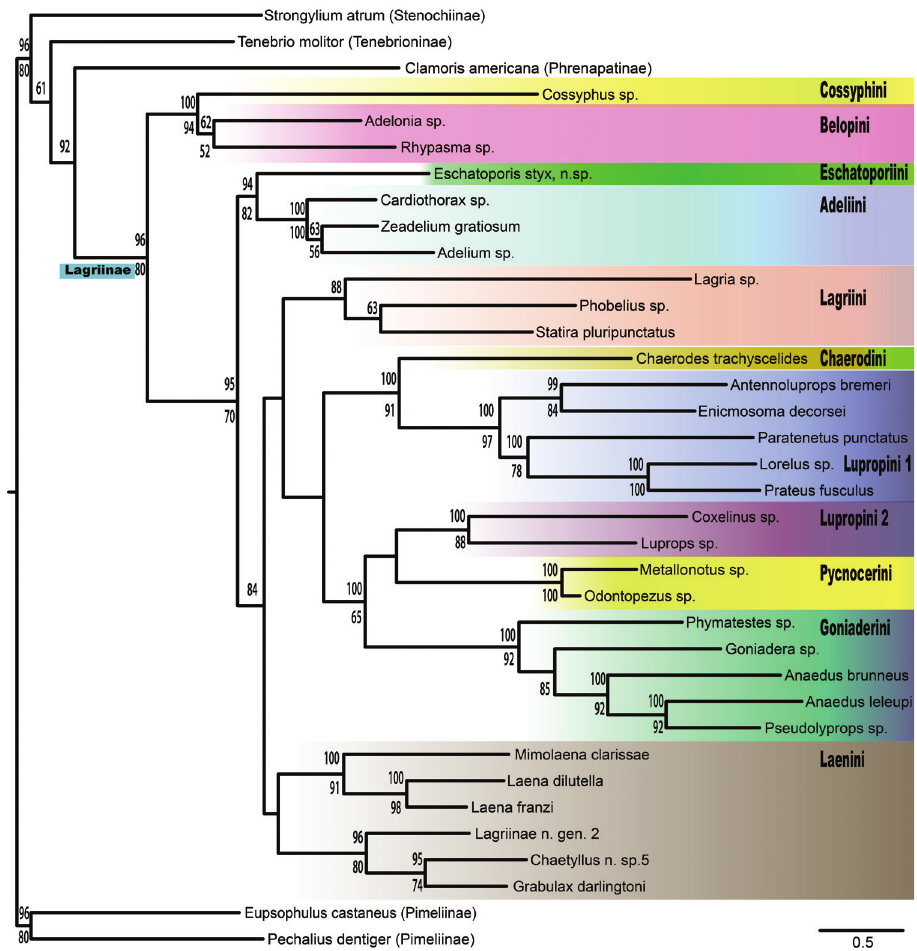
Figure 1. Maximum Likelihood tree from RaxML. Posterior probability values above branches and bootstrap values below. Clades colored according to tribe.